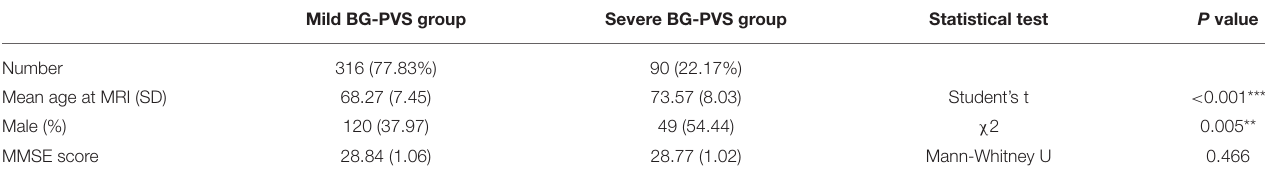
TABLE 1 | Demographic characteristics of the overall MRI sample classified according to the severity of BG-PVS.